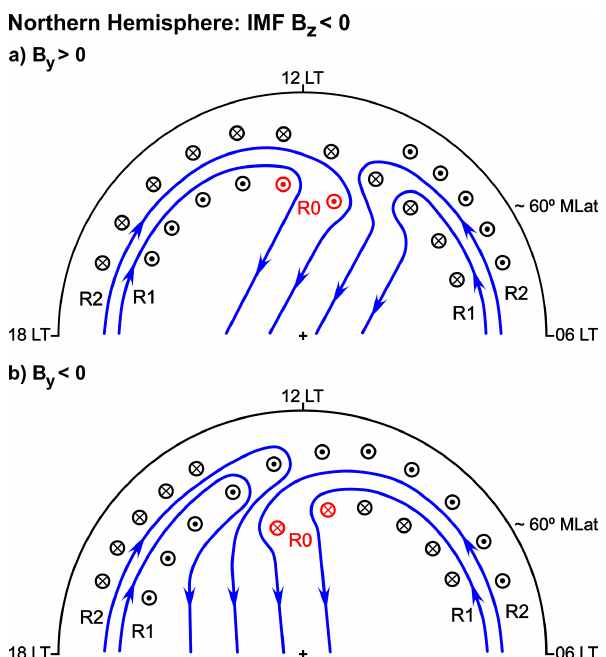
Fig. 10. Schematic of plasma streamlines (arrowed solid lines) and field-aligned currents in the Northern Hemisphere for southward IMF. Sketch (a) is for positive and (b) for negative IMF B y . Circled crosses represent downward currents into the ionosphere, while cir- cled dots represent upward currents out of the ionosphere. The re- gion 0, region 1, and region 2 currents are labelled “R0” (red), “R1”, and “R2” (black), respectively. Plasma streams are perpendicular to the gradients of FAC